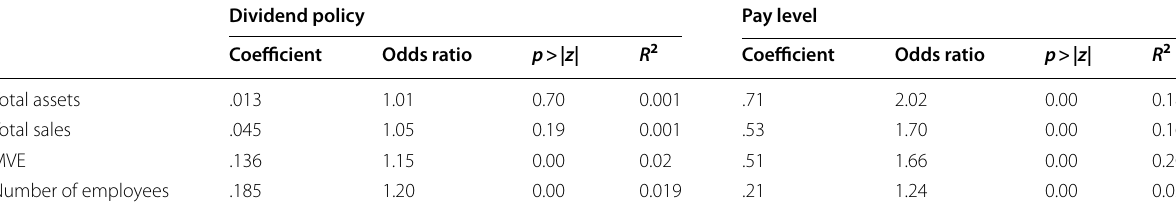
Dependent variable: dividend policy (Dummy); pay level (Dummy), n